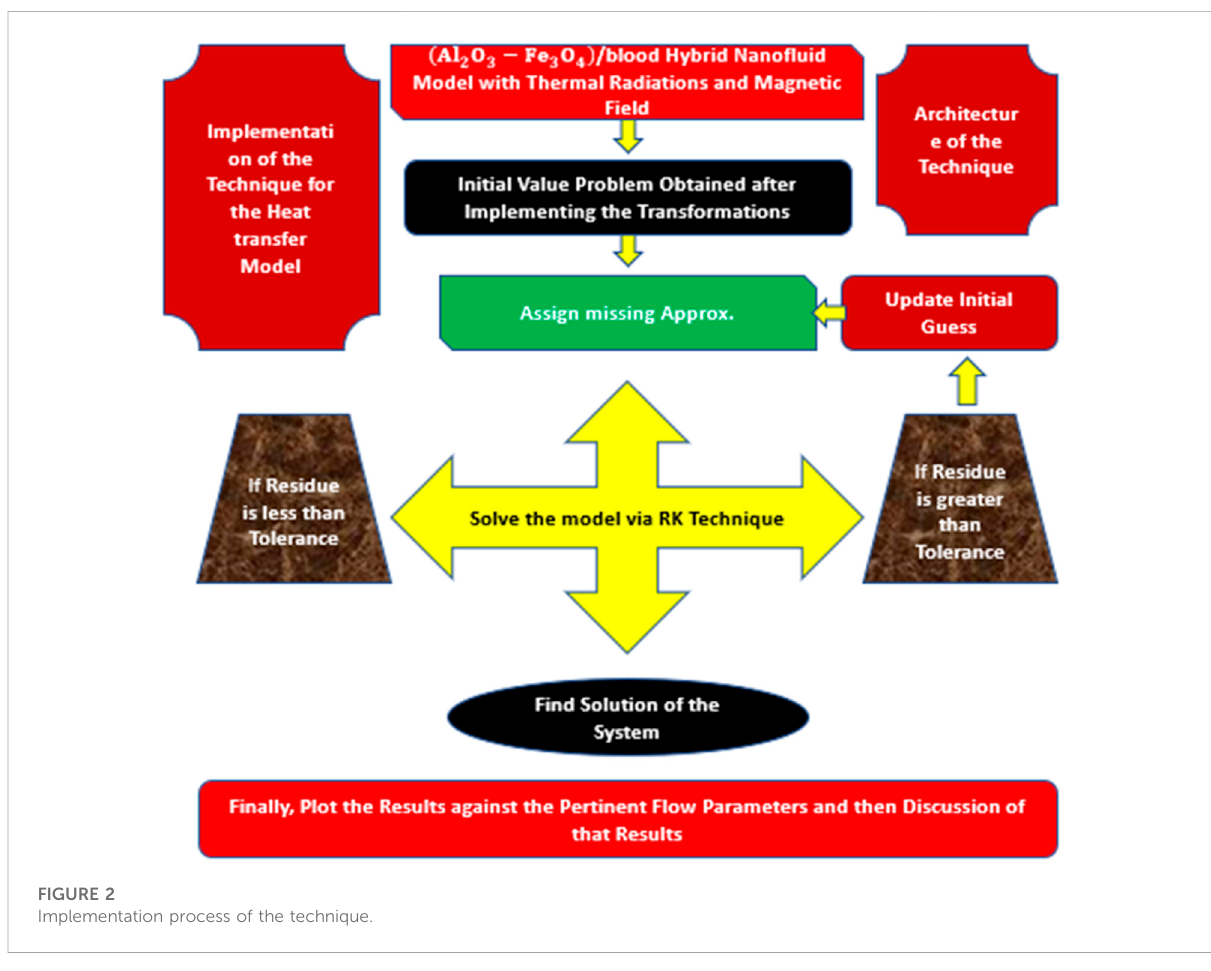
And, the continuity in Eq. 1 is clearly satis fi ed in the view of aforementioned similarity equations.